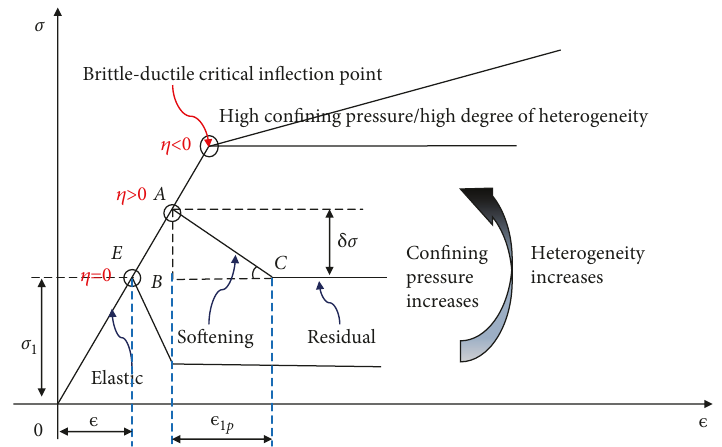
Figure 9: Idealized triaxial stress-strain curve of soft coal mass (revised from [32, 55,